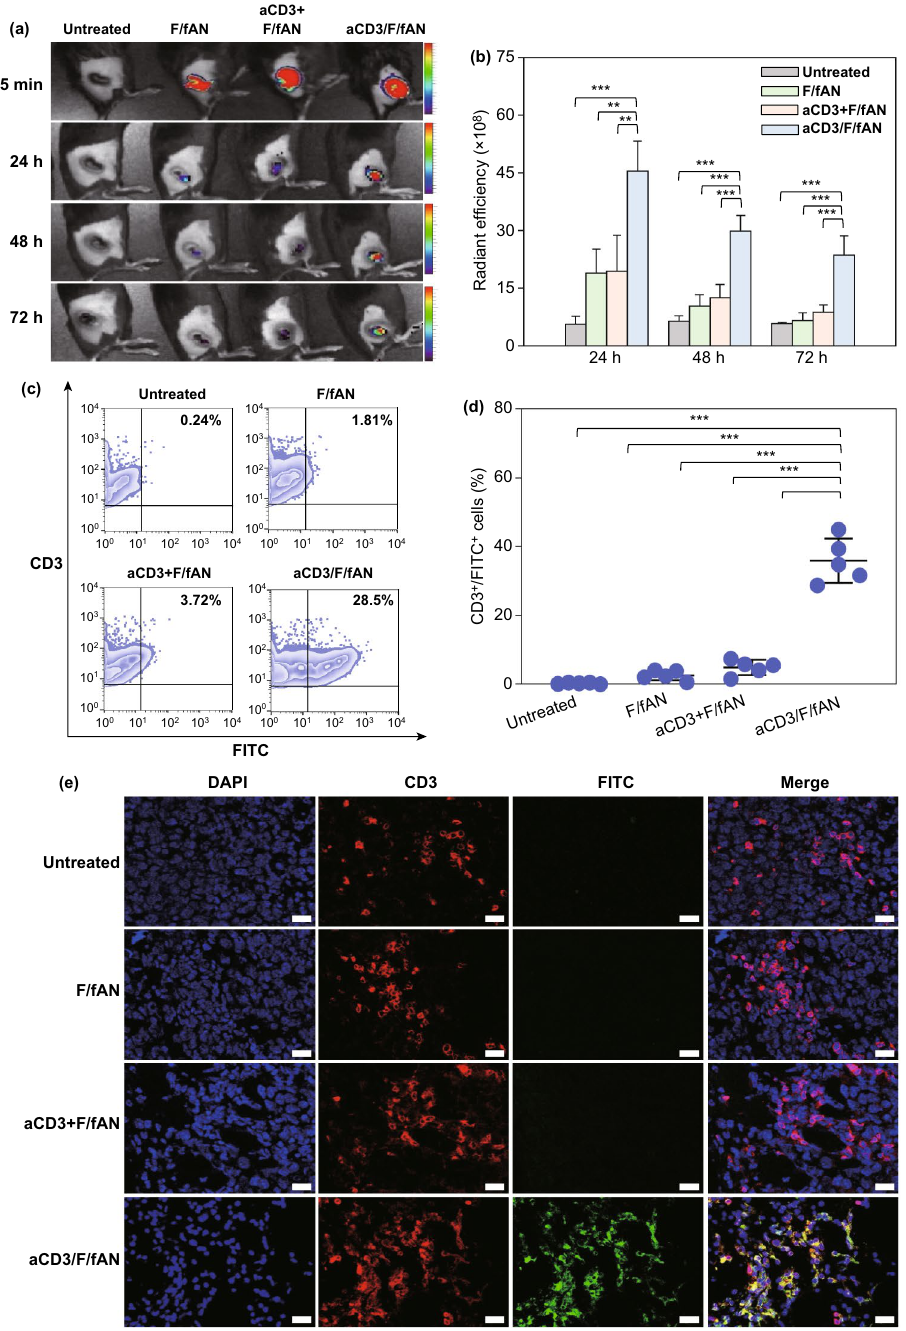
Fig. 8 In vivo T cell‑targeting ability of aCD3/F/ANs. T cell targeting ability was evaluated by intratumorally injecting mice (n = 3) with vari‑ ous nanoparticle preparations containing fenofibrate. a In vivo fluorescence at tumor sites, visualized at different time points. b Quantification of fluorescence in tumor sites at different time points (**P < 0.01, ***P < 0.001). c Uptake of nanoparticles in tumor‑resident T cells, analyzed by flow cytometry. d CD3 + FITC + T cell population, quantified for each treatment group (***P < 0.001). e Colocalization of nanoparticles (green) with CD3 + T cells (red), visualized by confocal microscopy. Scale bars: 20